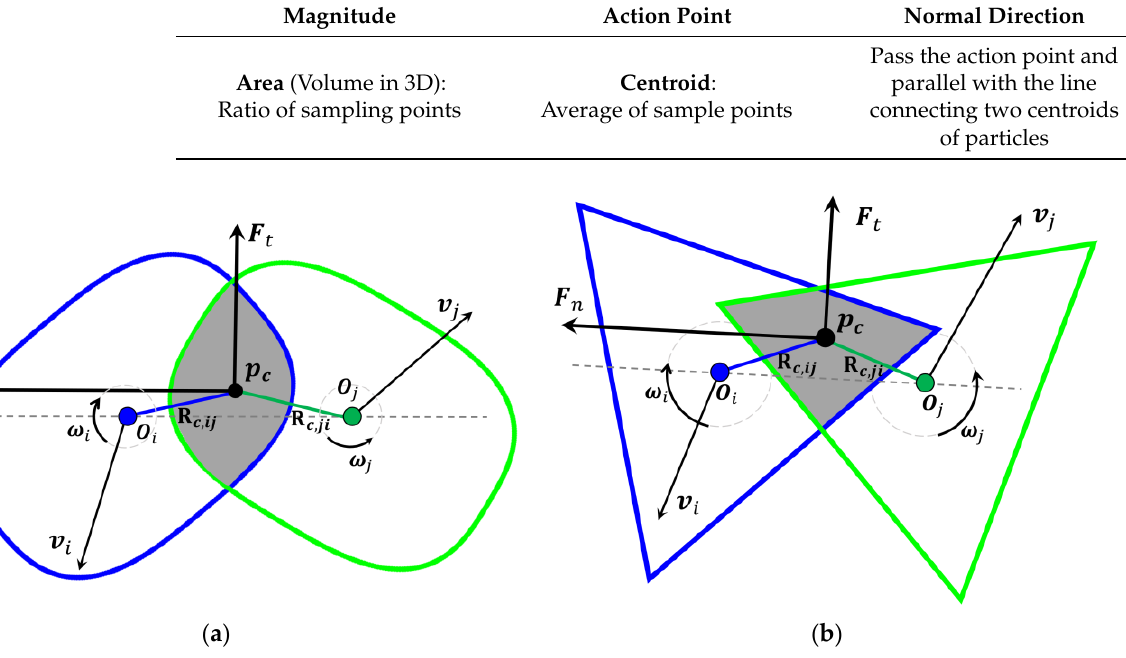
Table 3. Contact overlap features used in this paper.